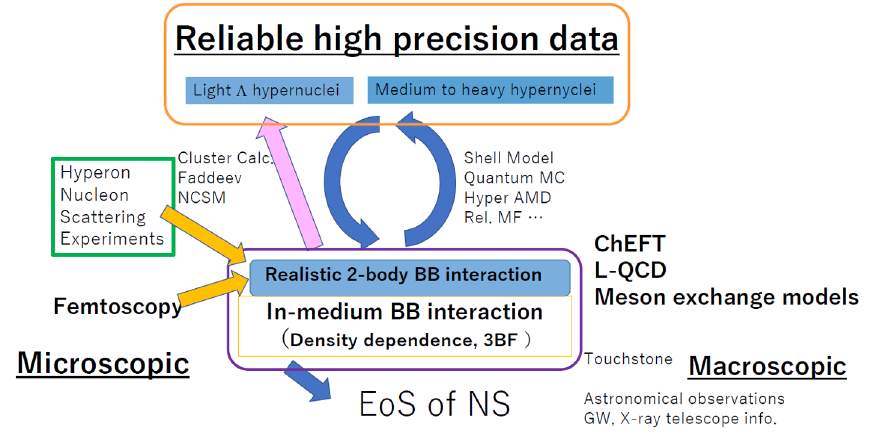
Figure 1. Strategy to solve the hyperon